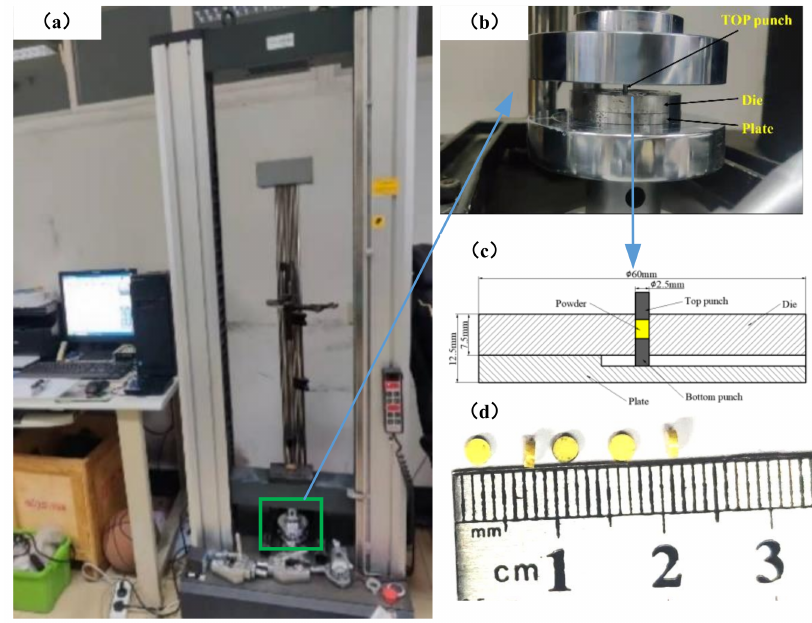
Figure 5. UTM4000 electron universal testing machine. Explanation in the